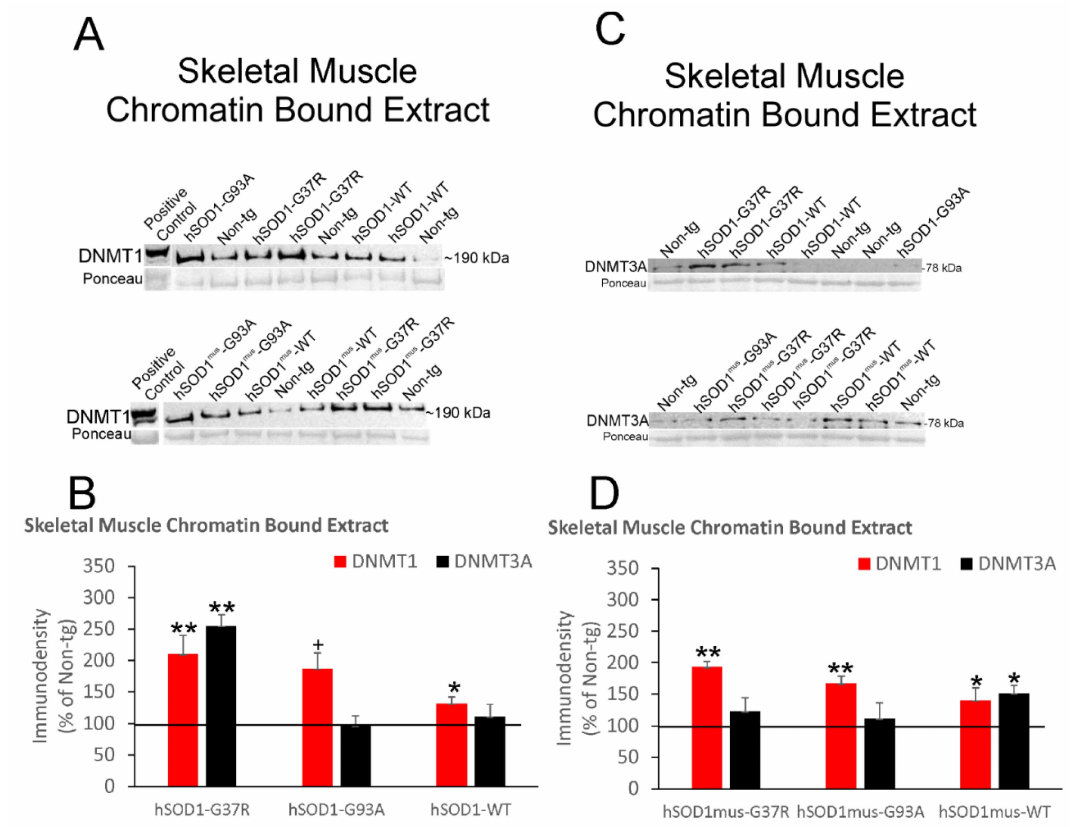
Figure 6. Western blot analysis of DNMT1 and DNMT3A protein levels in the chromatin bound extract of skeletal muscle from nonconditional hSOD1 tg mice and hSOD1 mus mice. Representative immunoblots for DNMT1 ( A ) and DNMT3A ( C ) are indicated. Different tg mouse lines were assign to lanes randomly. Sizes of DNMT1 and DNMT3A (in kDa) are indicated for each blot at right. Each blot had a positive control lane. Ponceau S-stained membranes show protein loading. ( B ) Protein IR levels (mean ± SD, as % of non-tg mouse immunodensity) for DNMT1 and DNMT3A in nonconditional hSOD1 mouse lines ( n = 5/genotype). * p < 0.05; + p < 0.01; ** p < 0.001. ( D ) Protein IR levels (mean ± SD, as % of non-tg mouse immunodensity) for DNMT1 and DNMT3A in hSOD1 mus mouse lines ( n = 5/genotype). * p < 0.05; ** p <